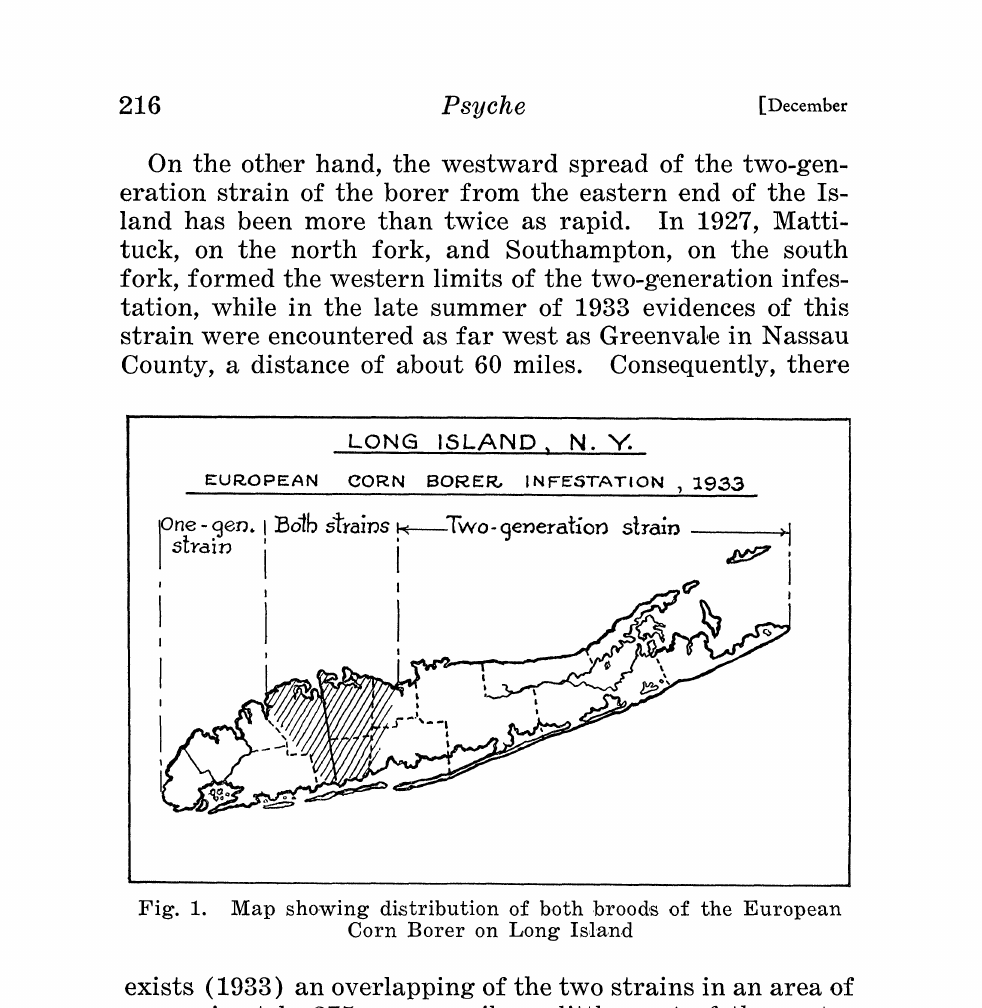
Fig. 1. Map showing distribution of both broods of the European Corn Borer on Long